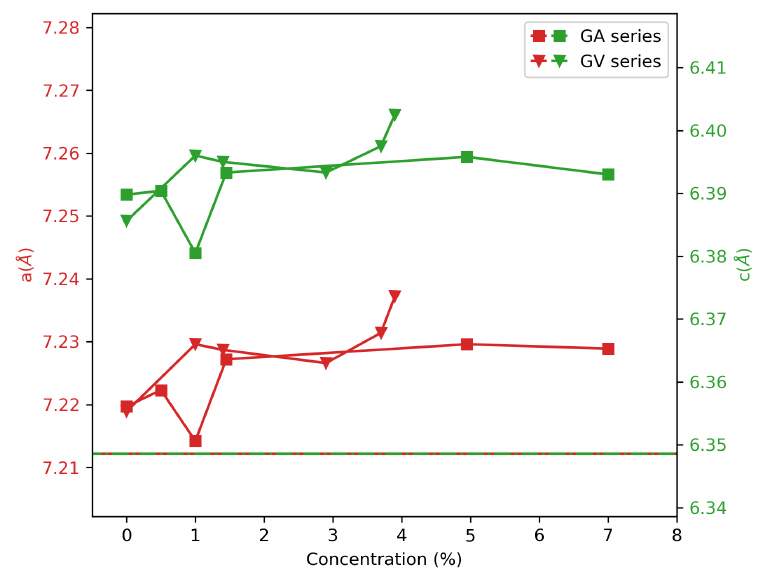
Figure 2. Lattice constants as obtained from the fit of the position of the XRD peaks. Concentrations are those obtained by the EDX measurements except for 0%, 0.5%, and 1%. The horizontal line shows the database values of the lattice constants.